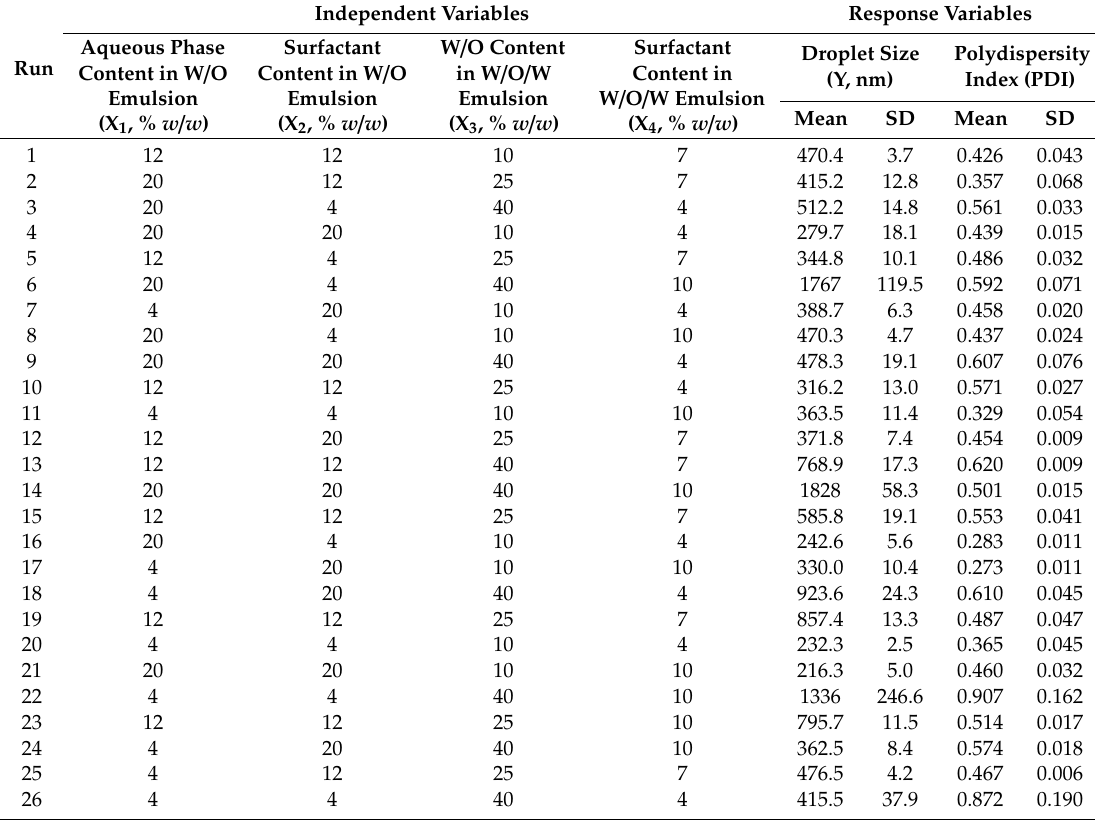
Table 1. Experimental matrix of W / O / W formulations based in a central composite design